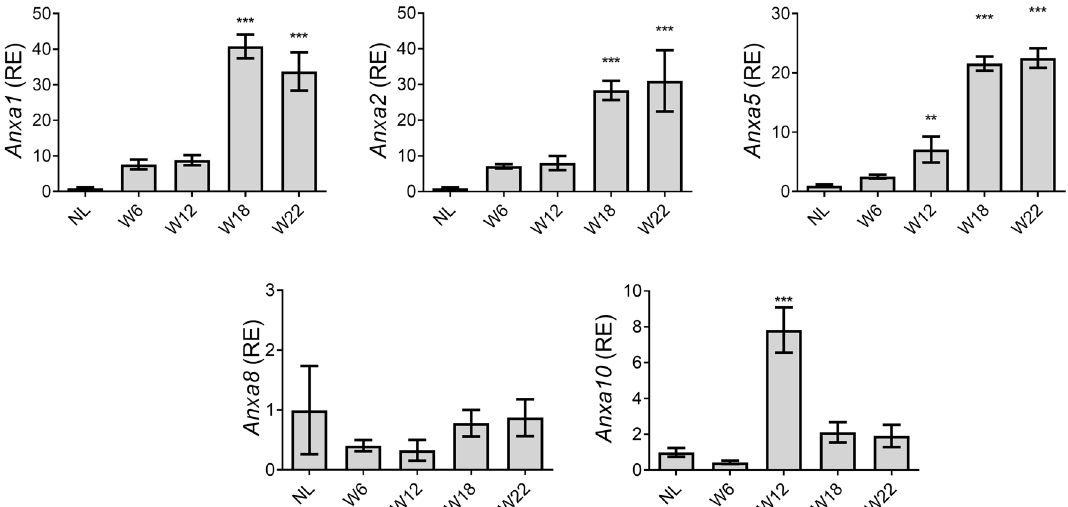
Figure 1. Expression of Anxa1, Anxa2, Anxa5, Anxa8, and Anxa10 genes during rat hepatocarcinogenesis. The relative mRNA levels of annexin genes in liver tissue were determined by RT-qPCR. Anxa1, Anxa2, Anxa5, Anxa8 , and Anxa10 expression was normalized to ribosomal 18 s mRNA level. Bars show the relative expression (RE) compared to the NL group and represent the mean ± SD. p values were calculated by the ANOVA test. n = 5 animals/group. NL normal liver, W week. *** p < 0.001; ** p <